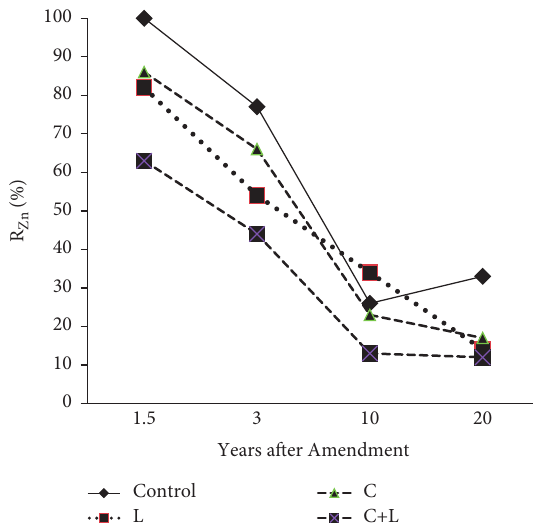
Figure 6: The relative concentrations of Zn ( R − 1 (HMP) (after Amirulloh � 100 × Zn/Zn Zn 0 -1.5) in topsoil amended with 60Mg waste ha and Salam (unpublished data, 2000) for 1.5 years, after [42] for 3 years, after [50] for 10 years, and after Susilowati and Salam (unpublished data, 2018) for 20 years; the concentration of Zn in the topsoil of control at 1.5 years was 116.6mg · kg − 1 (Zn 0 -1.5) (L: lime at 5Mg · ha − 1 ; C: cassava-leaf compost at 5Mg · ha − 1 ).